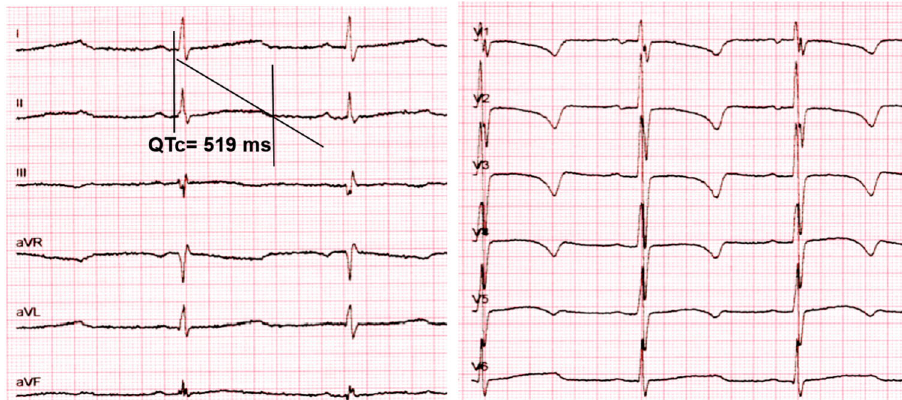
Fig. 1 QTc value of the index patient. The QT interval corrected for heart rate (QTc) was measured in lead II from 12-lead